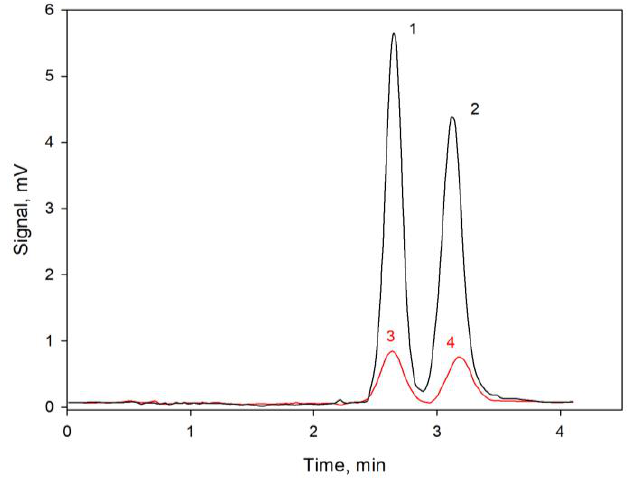
Figure 4. GC determination of benzene (1, 3) and toluene (2, 4) in a model solution (5 mg/L) with preconcentration by a selective adsorption of the gas-extractant (1, 2) and without it (3, 4). СО 2 flow rate—30 mL/min, time—2 min. Separation column—Chromaton N-AW (60–80 mesh) coated with 5% OV-17.